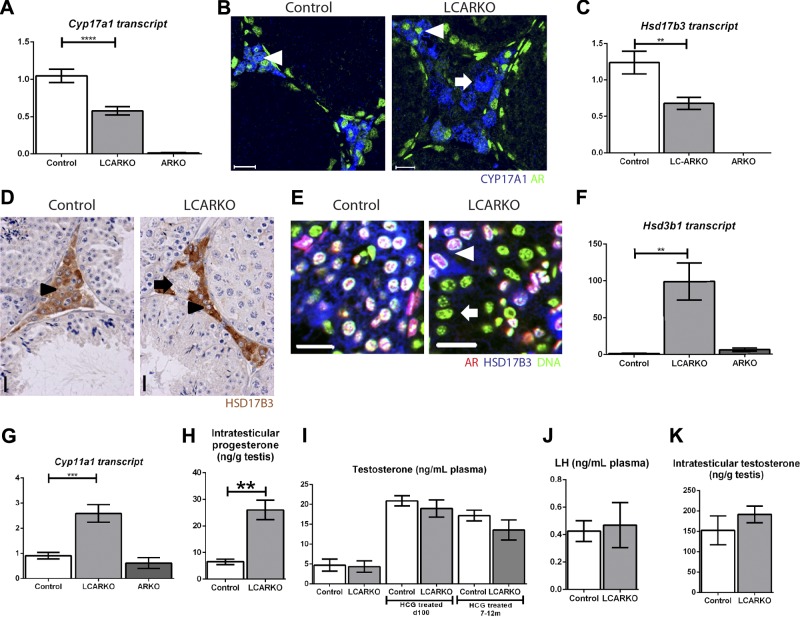
LCARKO testes have changes in steroidogenic enzyme expression but produce normal levels of T. A) Cyp17a1 gene expression is significantly decreased (****P < 0.0001) in LCARKO testis compared to controls at d 80 and is absent in ARKO testis. B) AR immunostaining (green) is seen in the nuclei of CYP17A1 (blue)-positive Leydig cells in controls (arrowhead). Both AR-positive (arrowhead) and -negative (arrow) cells in LCARKOs express CYP17A1. Scale bars, 20 µm. C) Hsd17b3 gene expression is significantly decreased (**P < 0.01) in LCARKO testis compared to controls at d 80 and is absent in ARKO testis. D) Two populations of Leydig cells can be seen in the LCARKO: an HSD17B3-positive population (arrowheads), and an HSD17B3-negative population (arrow). Scale bars, 20 μm E) AR immunostaining (red) is seen in the nuclei of HSD17B3 (blue)-positive Leydig cells in controls. In LCARKOs, HSD17B3 is localized to AR-positive cells (arrowhead), but not AR-negative cells (arrow). Scale bars, 20 µm. F) Hsbd3b1 gene expression is significantly increased (**P < 0.01) in LCARKO testis compared to controls at d 80. G) Cyp11a1 gene expression is significantly increased (***P < 0.001) in LCARKO testis compared to controls at d 80. H) Intratesticular progesterone is significantly increased (**P < 0.01) in LCARKO compared to control mice at d 80. I) Plasma T levels are not significantly different between control and LCARKO mice at d 80, d 100 hCG treated, and 7–12 mo hCG treated. J) Plasma LH levels are not significantly different between control and LCARKO mice at d 80. K) ITT levels are not significantly different between control and LCARKO testes at d 80.